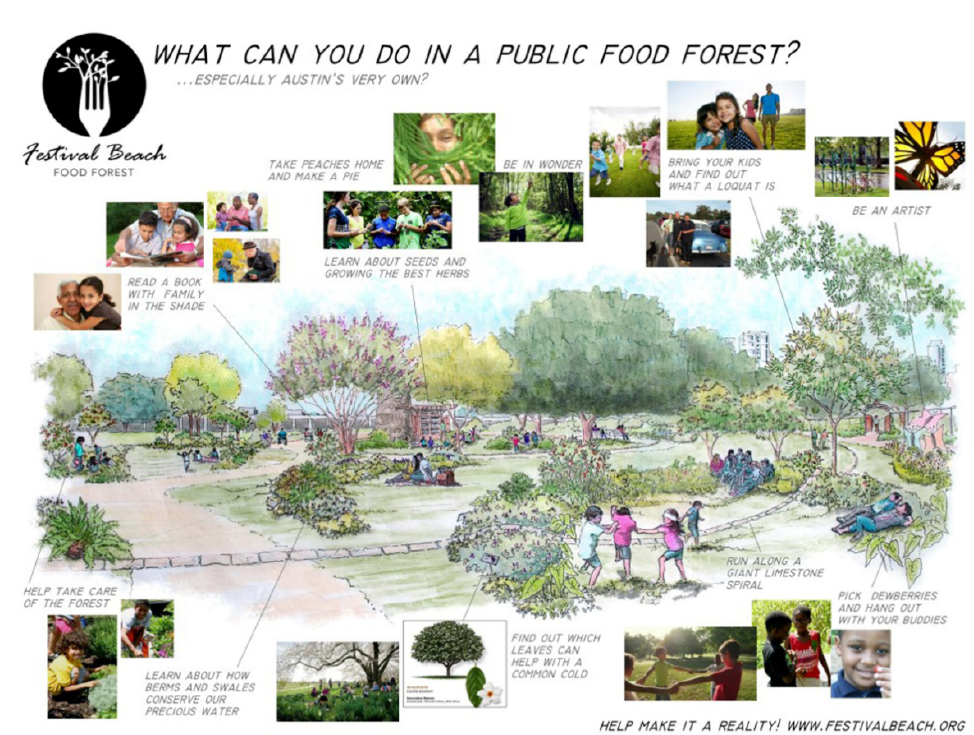
Figure 4. Festival Beach Food Forest is a pilot project in Austin, Texas [45].